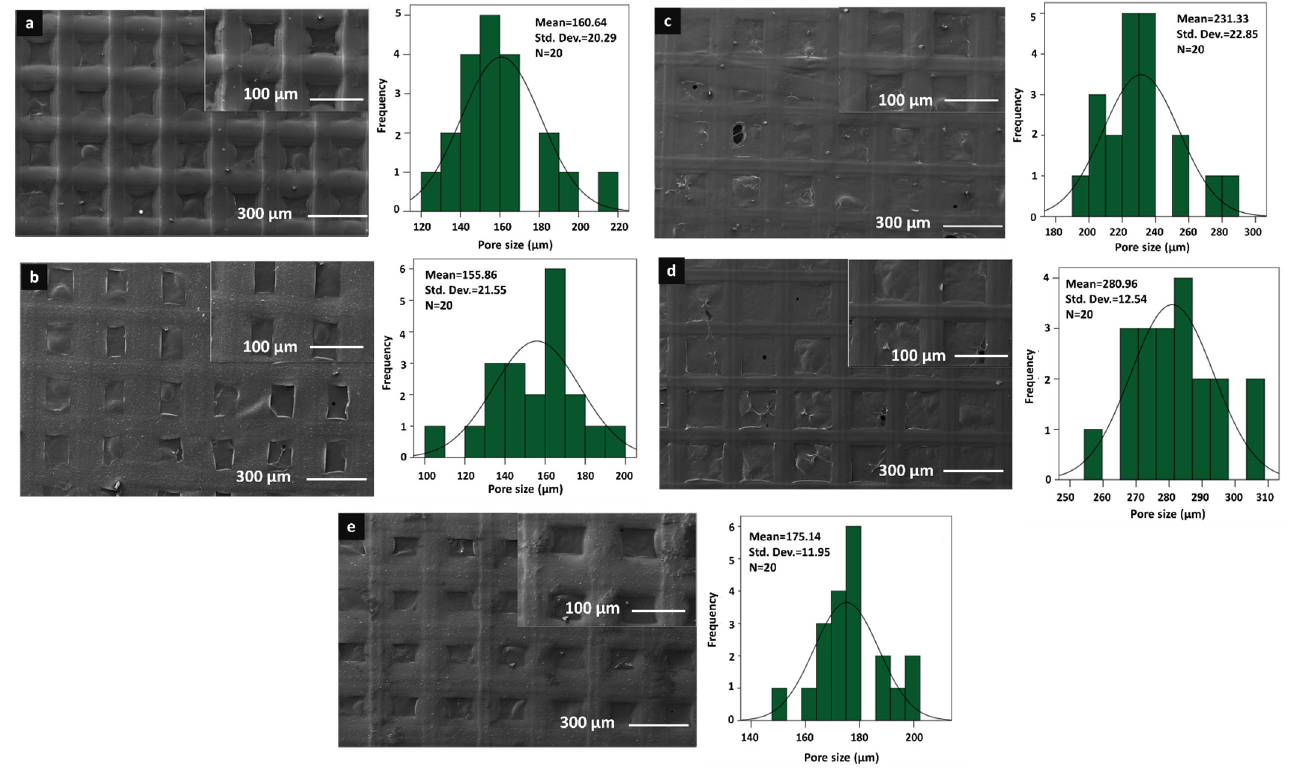
Figure 2. SEM images of the 13% PVA/3% PE ( a ), 13% PVA/5% PE ( b ), 13% PVA/7% PE ( c ), 13% PVA/9% PE ( d ), and 13% PVA/11% PE ( e ) scaffolds.